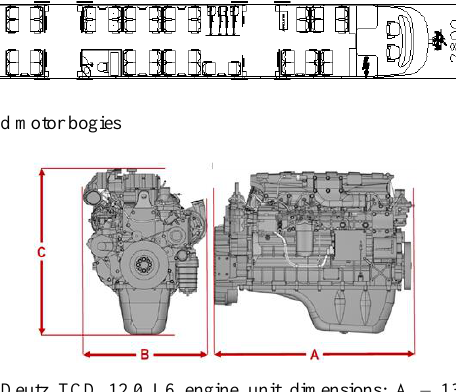
Fig. 12. Deutz TCD 12.0 L6 engine unit dimensions: A – 1335 mm, B – 853 mm, C – 1156 mm [8]